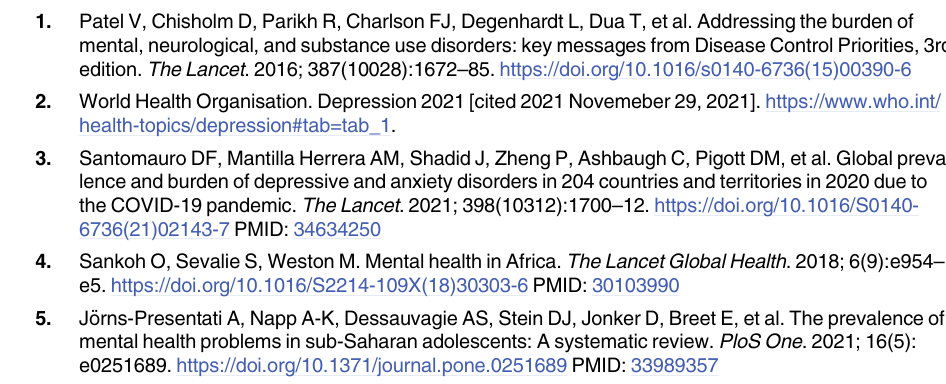
S1 Table. Prevalence of depression in study populations in